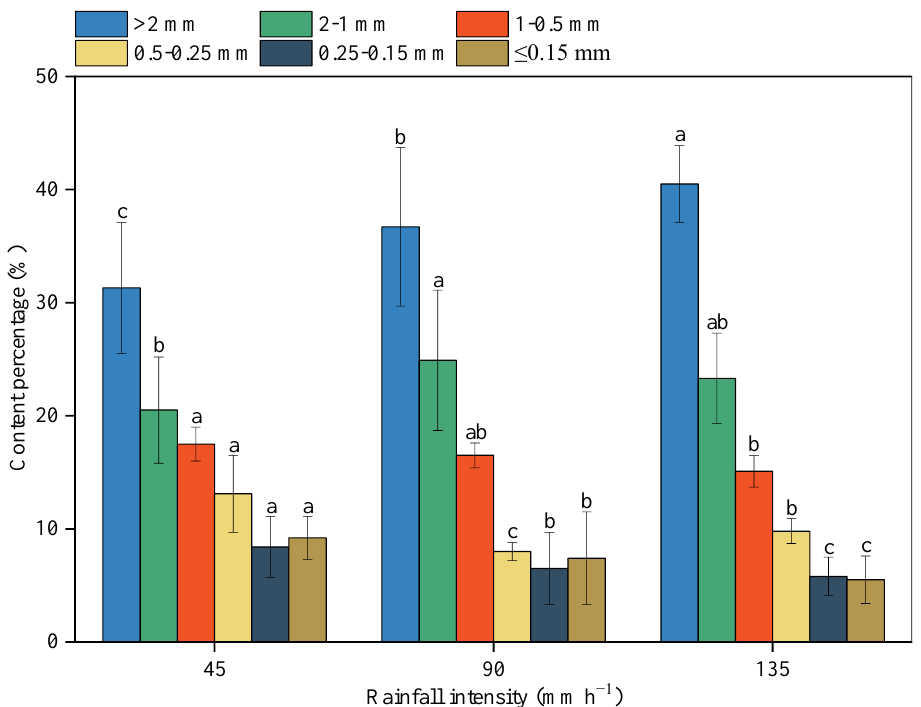
Figure 8. The sieved size and weight percentage of the eroded surface soil after rainfall simulation. The different letters indicate significant differences among different rainfall intensities ( p < 0.05).